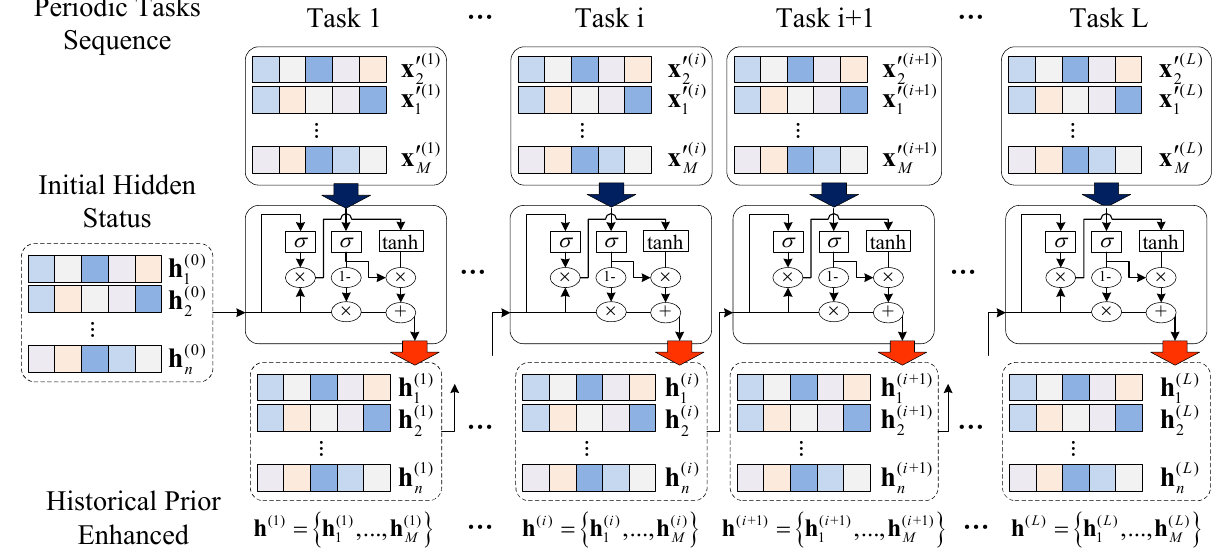
Figure 4. Illustration of the GRU-based sequential encoding of features in tasks in the continual meta-learning